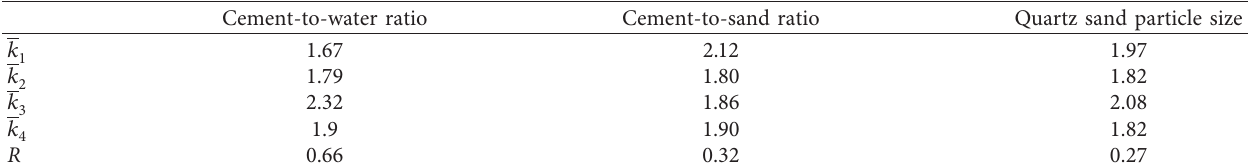
Table 5: Range analysis of elastic